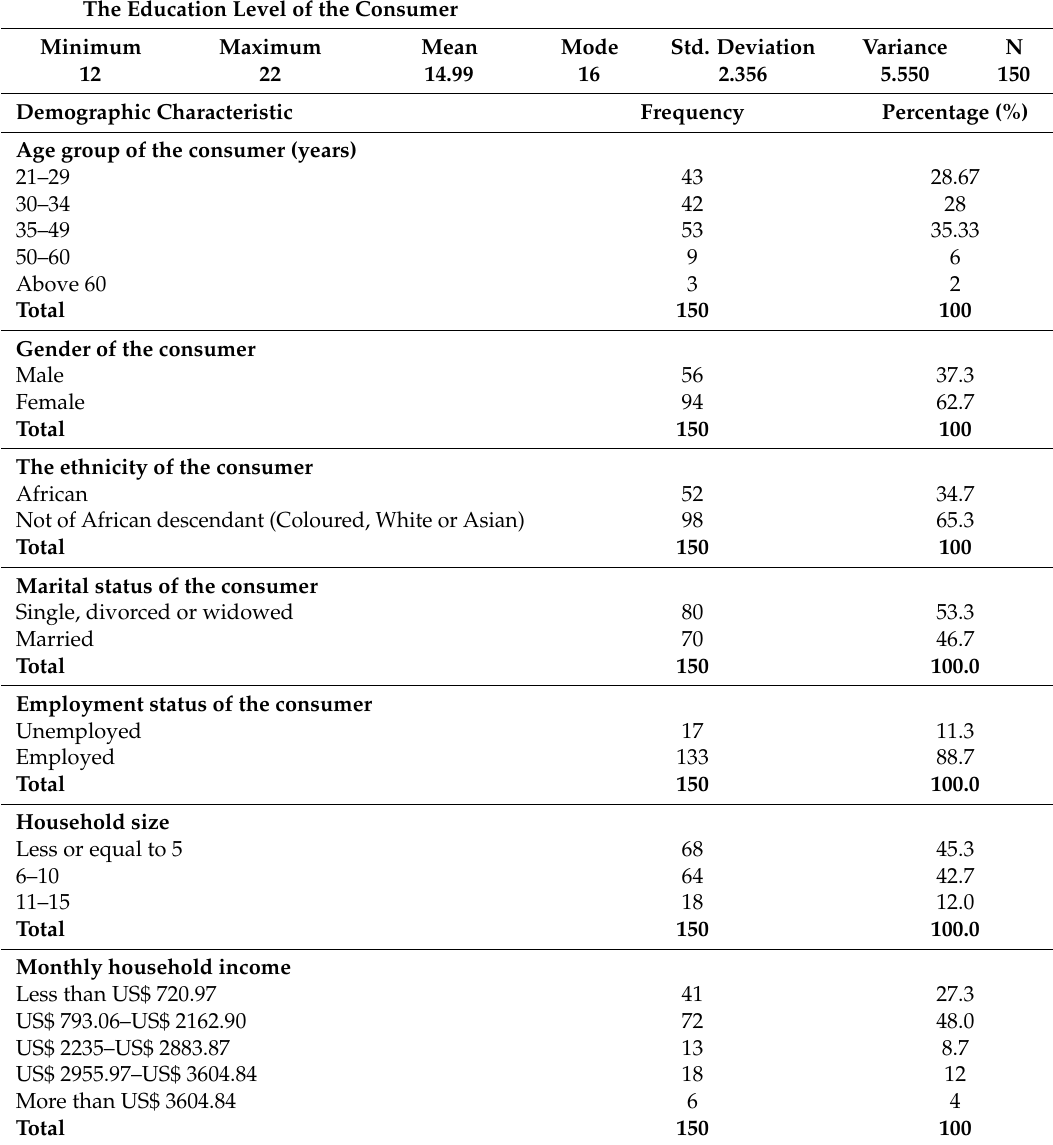
Table 2. Demographic characteristics of the interviewed consumers in Shelly Centre (n =